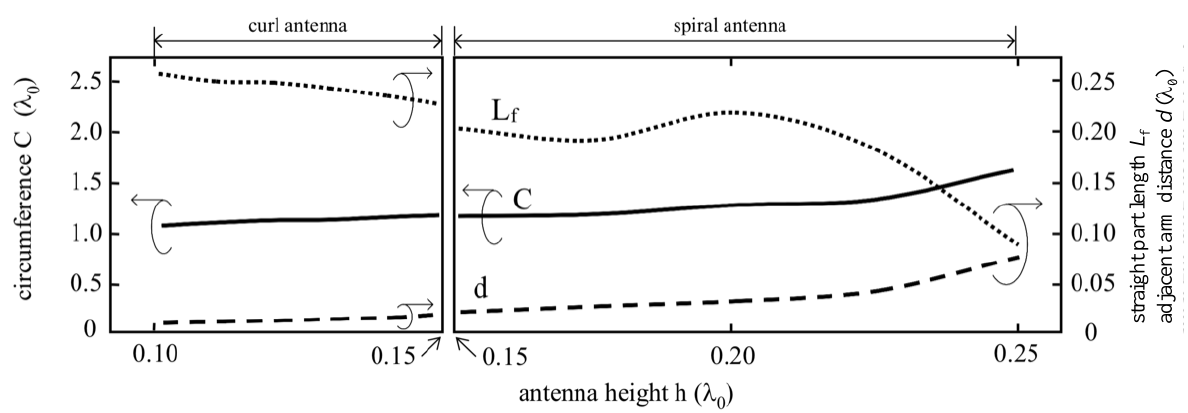
Figure 2. Configuration parameters optimized for CP radiation versus antenna height h . The frequency bandwidth for a 3 dB axial ratio criterion against the antenna height h